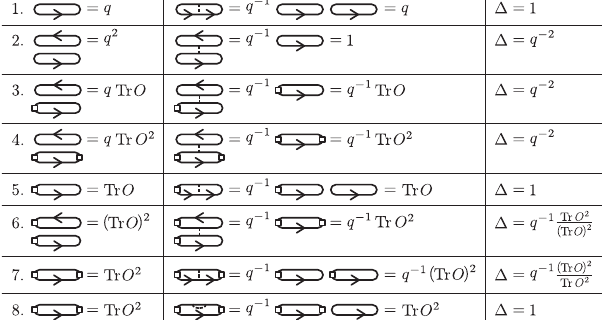
FIG. 11. Enumeration of all distinct ways in which a contrac- tion may be added to a site diagram. Columns from left to right are as follows. (i) Eight distinct combinations of one or two loops, before addition of a contraction, with associated contributions to FIG. 13. Top: The block representation of a leading DW O ð G ð m − 1 Þ diagram for h exp ½ − S 2 ð t Þ(cid:2)i . The top row (the zeroth row) denotes i Þ . Three types of loop appear, containing zero, one, or two local operators O indicated using open squares. (ii) The same the effective blocks that represent the structure of traces in after adding a contraction shown as a dashed line and redrawn subregions A and B [Fig. 9(b) bottom left]. The dashed line m Þ represents a light cone outside of which all unitary pairs can be purely as loops, with associated contributions to O ð G ð i Þ . annihilated as described in Fig. 2. The red line represents costly (iii) Values of Δ ð m Þ arising from each contraction obtained as boundaries (between blocks of different contraction types; see the ratio of contributions in columns (ii) and (i). Appendix B 2 and Table I). Bottom: The correspondence between blocks and the symbols used in the bottom right of Fig.